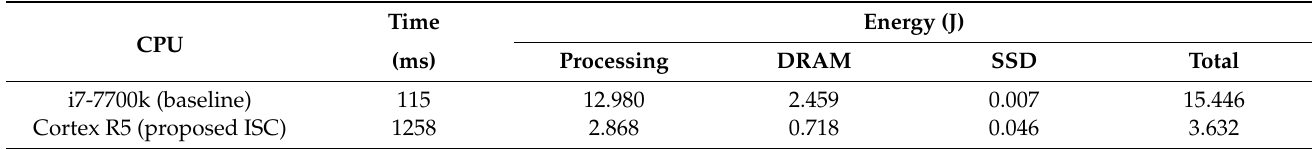
Table 5. Focus fancam off-line run time and